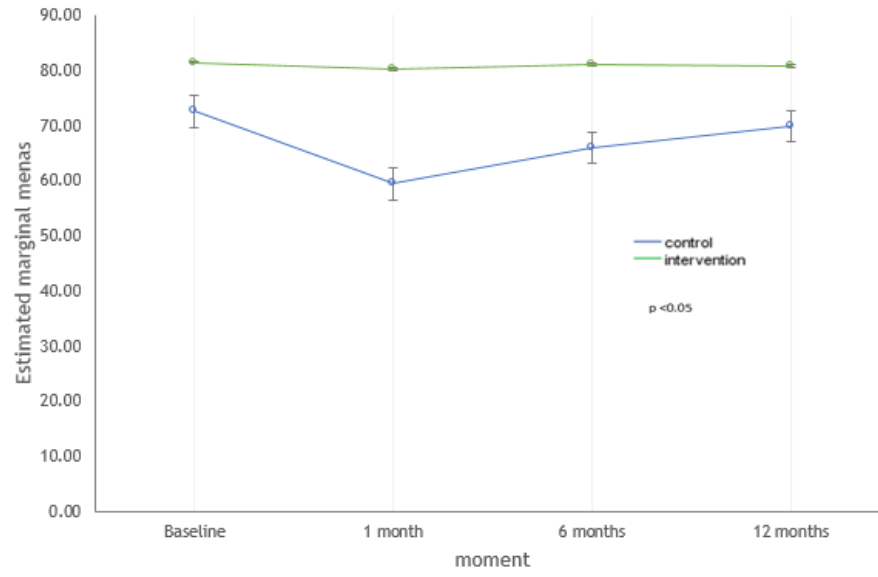
Figure 4. Evolution of the social functioning dimension: intervention vs. control group.